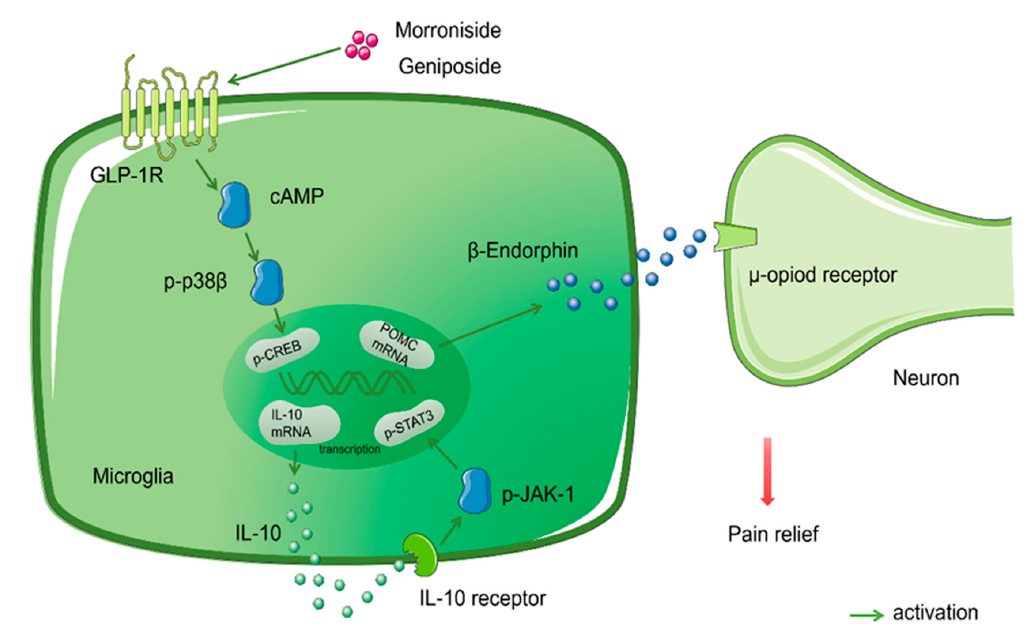
Figure 2. Glycosides and membrane receptors. Morroniside and geniposide activated GLP-1R (one of GPCRs), via IL-10/ β -Endorphin signaling pathways mediated analgesia in neuropathic